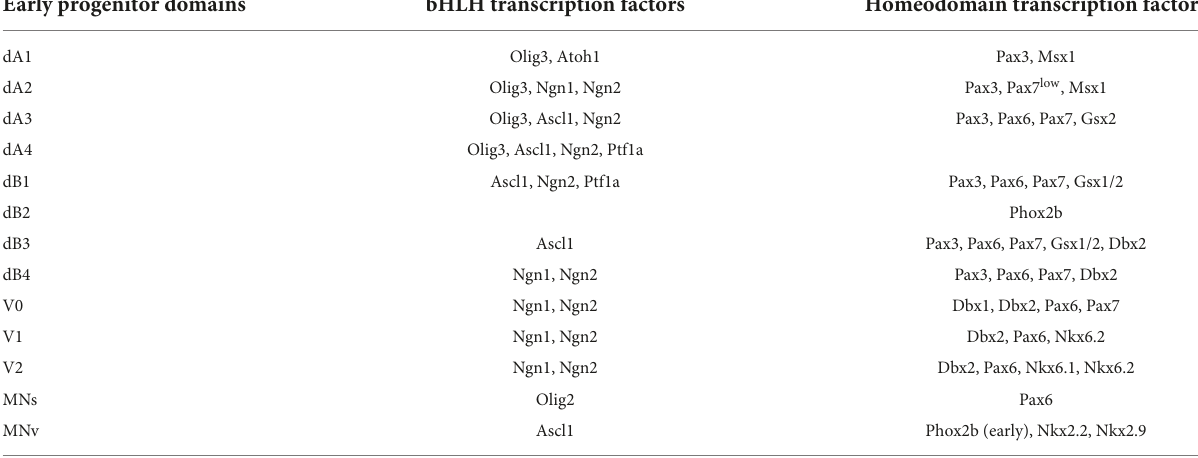
TABLE 1 Transcription factors expressed in progenitor domains of the developing